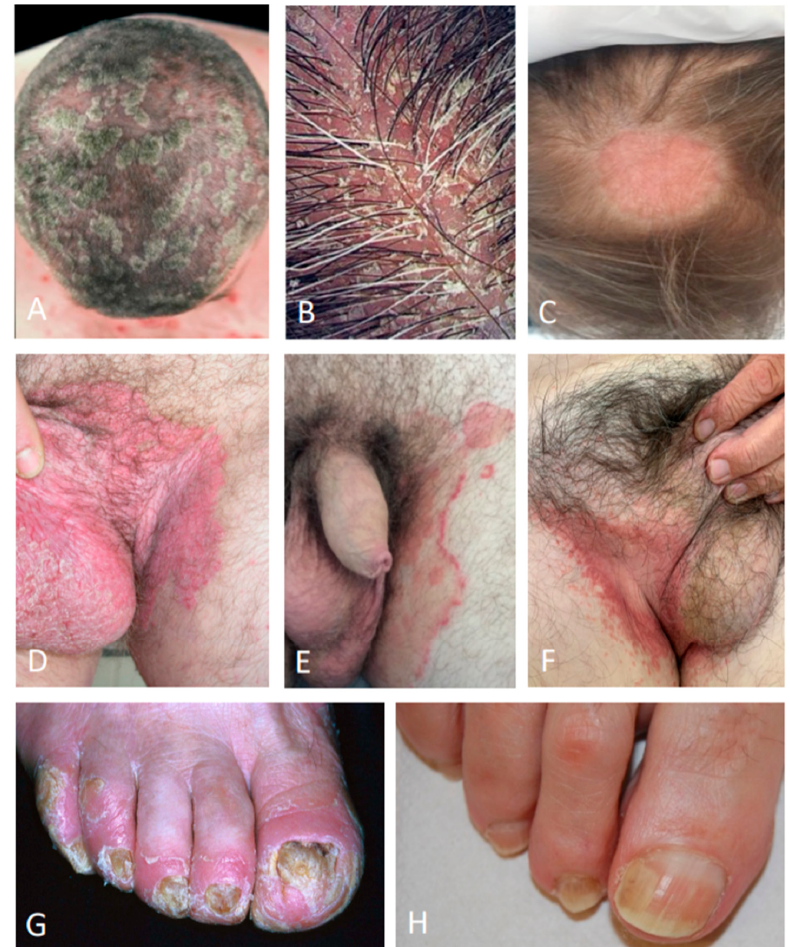
Figure 1. Di ff erential diagnosis of the scalp psoriasis ( A ); seborrheic dermatitis ( B ); tinea capitis ( C ); inverse psoriasis of the inguinal area ( D ); tinea cruris ( E ); candidiasis ( F ); nail psoriasis ( G ); traumatic onycholysis ( H